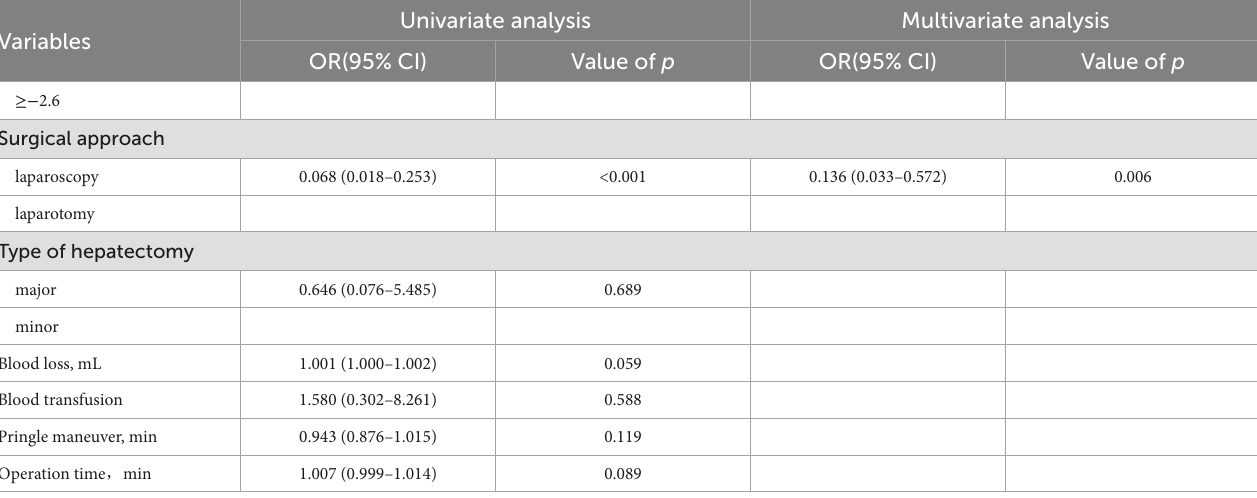
TABLE 4 Postoperative outcomes after hepatectomy in patients with benign liver diseases classified by muscle mass and muscle strength. Variables Overall complications, n (%)